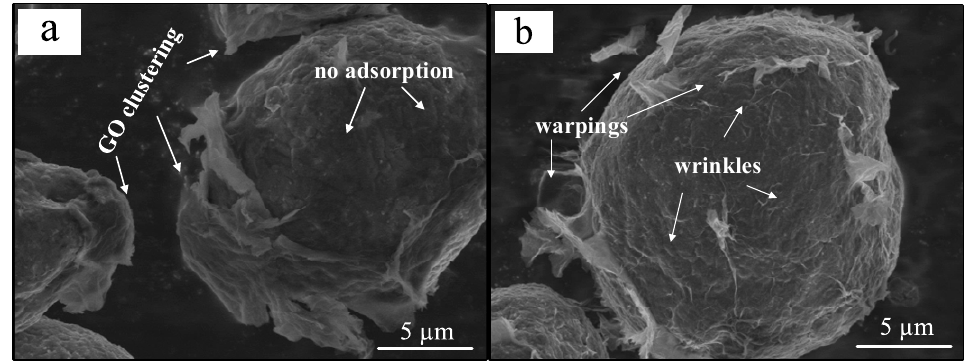
Figure 5. The SEM images of the composite powders: ( a ) GO clustering in unmodified 7075 Al powders; and ( b ) uniform adsorption of GO achieved by CTAB modification.